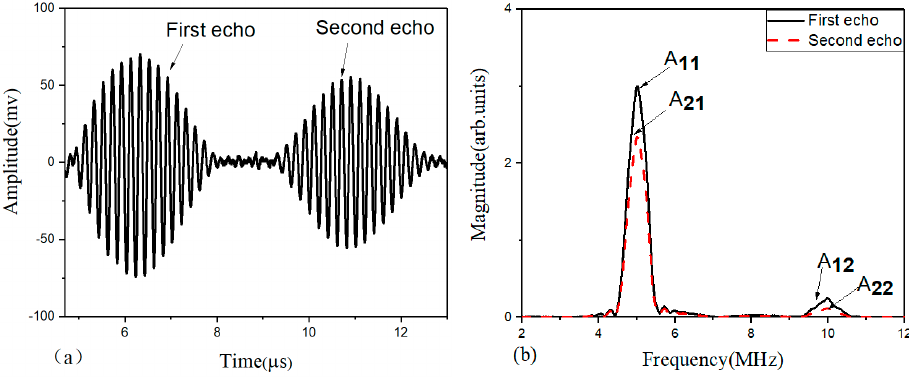
Figure 2. ( a ) Typical time domain signal, ( b ) frequency spectrogram.